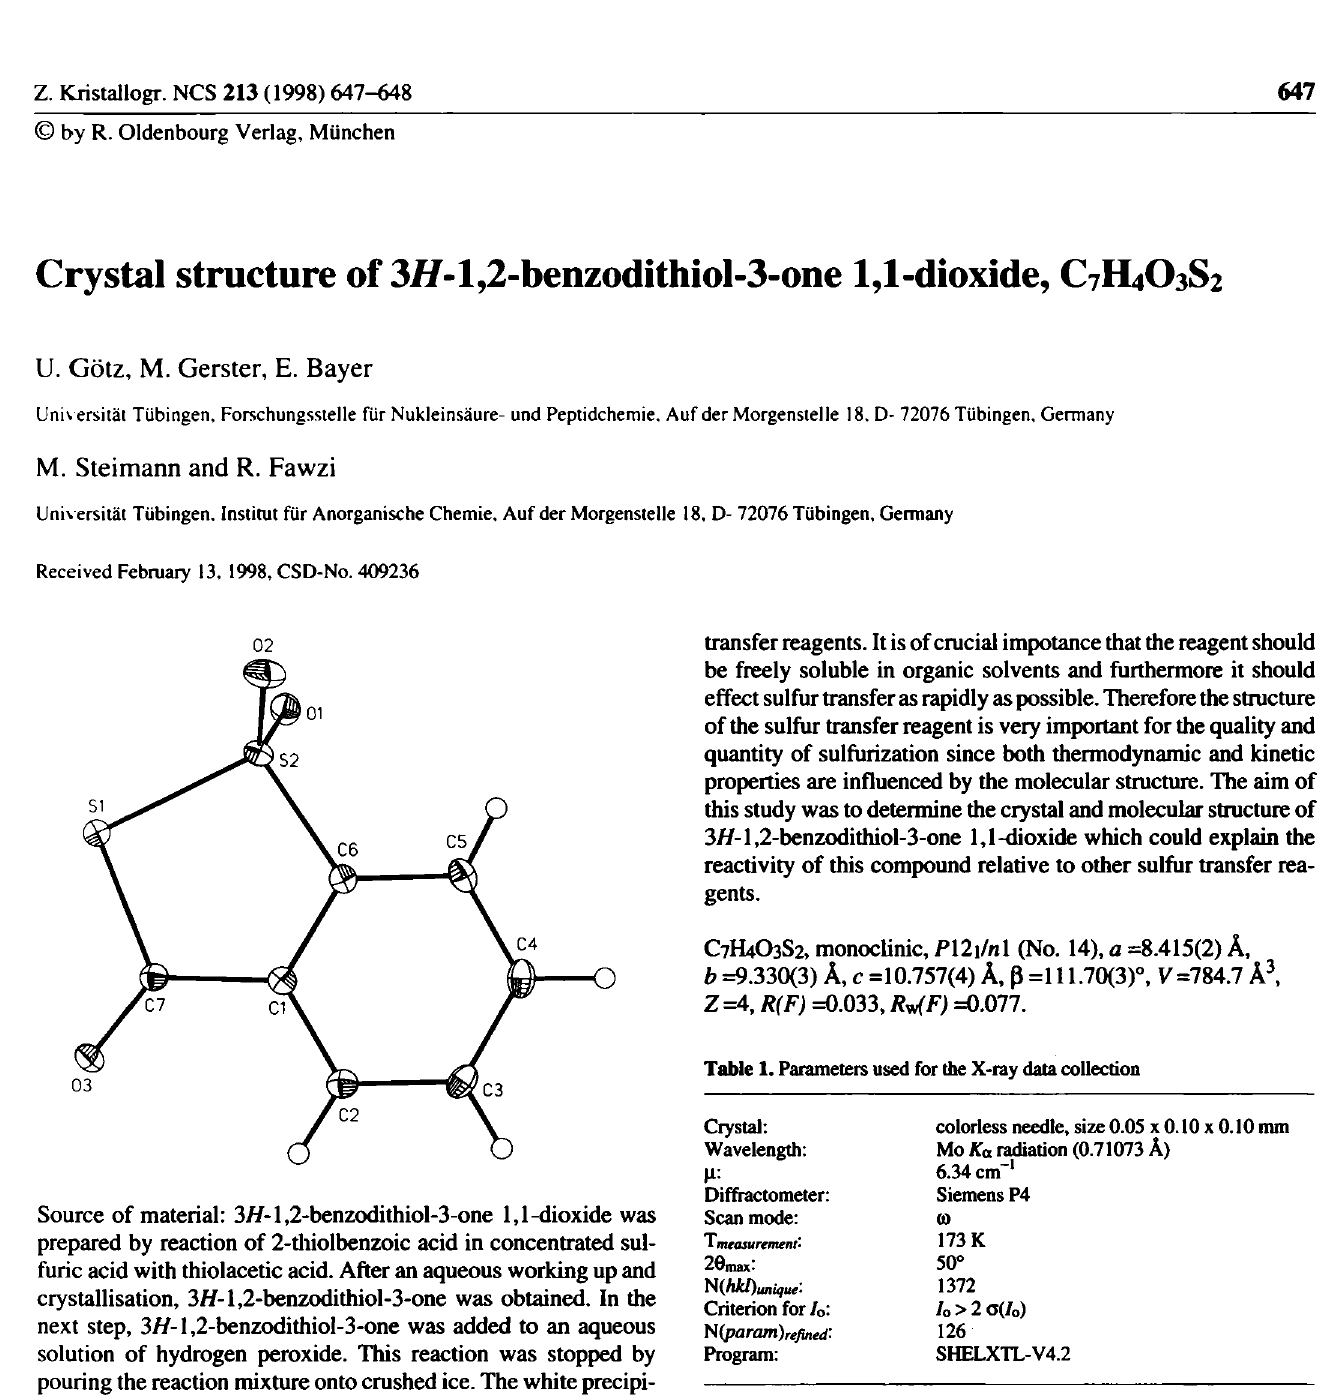
Table 2. Final atomic coordinates and displacement parameters (in